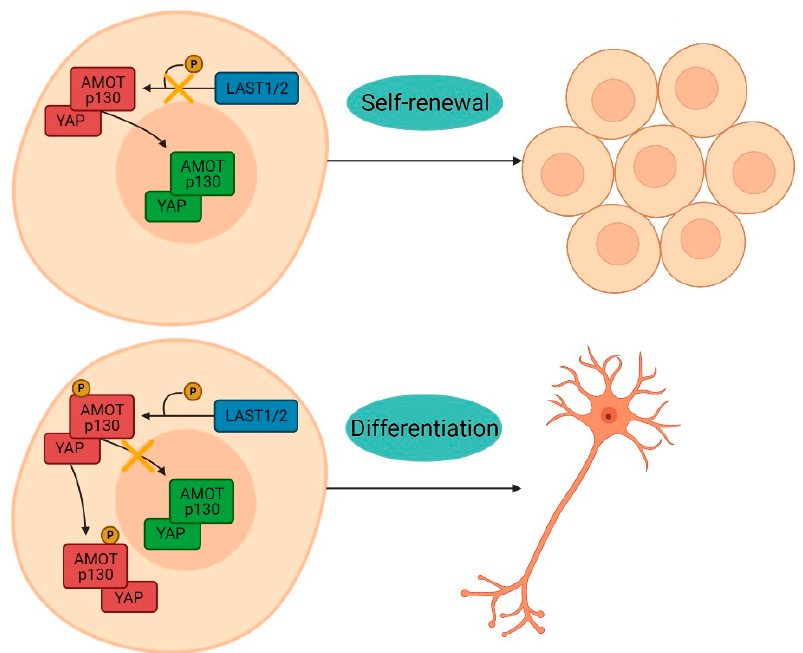
Figure 12. YAP/AMOT interaction. When phosphate-binding does not occur, both AMOT and YAP move to the nucleus, where YAP promotes cell proliferation. However, when phosphate is attached at the serine 176 position, AMOT predominantly interacts with YAP on the cell surface to stimulate neuronal differentiation.